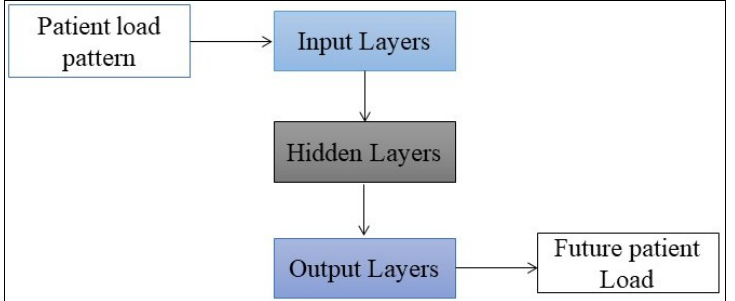
Figure 3. Proposed Deep Learning